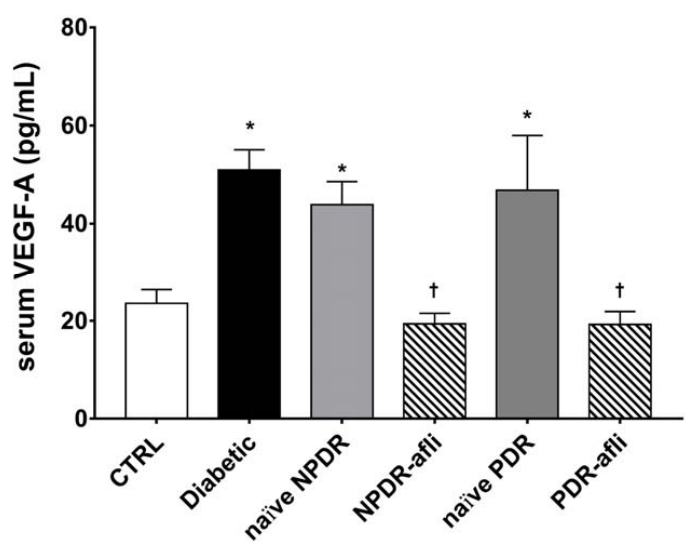
Figure 2. VEGF-A serum levels. After 7 days, aflibercept treatment significantly ( p < 0.05) decreased VEGFA serum levels in NPDR and PDR patients, compared to diabetic patients without signs of DR, and compared to untreated naïve NPDR and PDR groups. * p < 0.05 vs. CTRL; † naïve vs. aflibercept (afli) treatment.